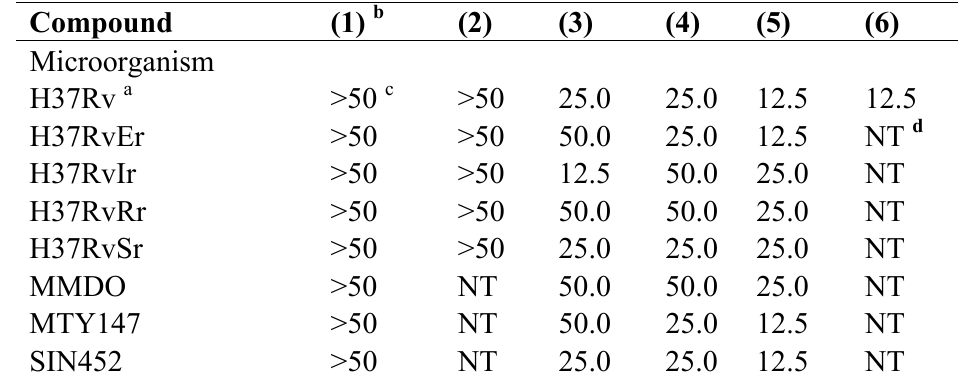
Table 1. Antimycobacterial activity ( Minimum inhibitory concentration [MIC] µg/mL) of the compounds isolated from Aristolochia brevipes